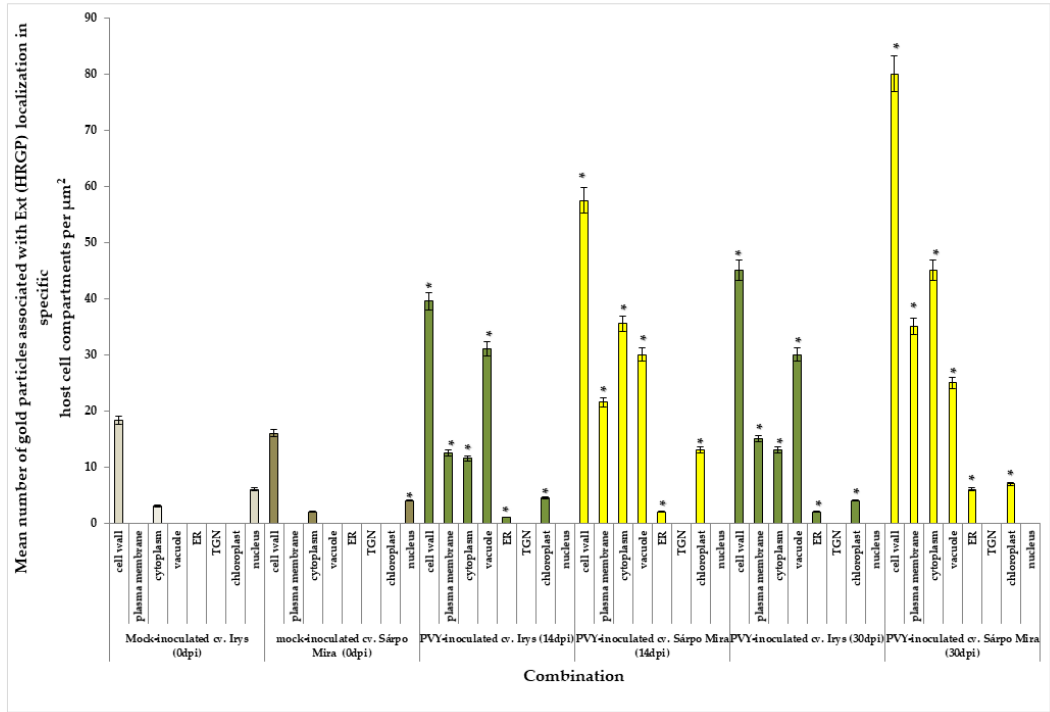
Figure 10. Statistical significance assessment of immunogold localization of extensins (HGRPs) in host cell compartments of mock- and PVY-inoculated potato plants (susceptible and resistant). The figure presents the mean numbers of gold particles located in specific compartments per µ m 2 . The light bronze charts present HRGP extensin immunogold localization in cell compartments of mock-inoculated Irys at 0 dpi. The dark bronze charts present HRGP extensin immunogold localization in cell compartments of mock-inoculated S á rpo Mira at 0 dpi. The dark green charts present HRGP extensin immunogold localization in PVY-inoculated Irys at 14 and 30 dpi. The yellow charts present HRGP extensin epitope immunogold localization in PVY-inoculated S á rpo Mira at 14 and 30 dpi. Quantification of immunogold localization was performed using ANOVA. The mean values of gold particles localization were evaluated at the p < 0.05 level of significance using the post-hoc Tukey HSD test. Statistically significant values after mock or virus inoculation are marked by asterisks (*) above the